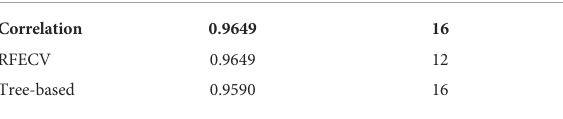
TABLE 3 Evaluation metrics and results of feature selection algorithms.